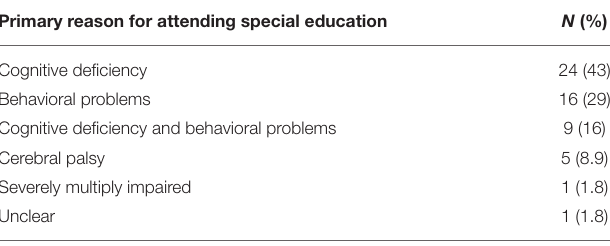
TABLE 2 | Reasons for attending special education.